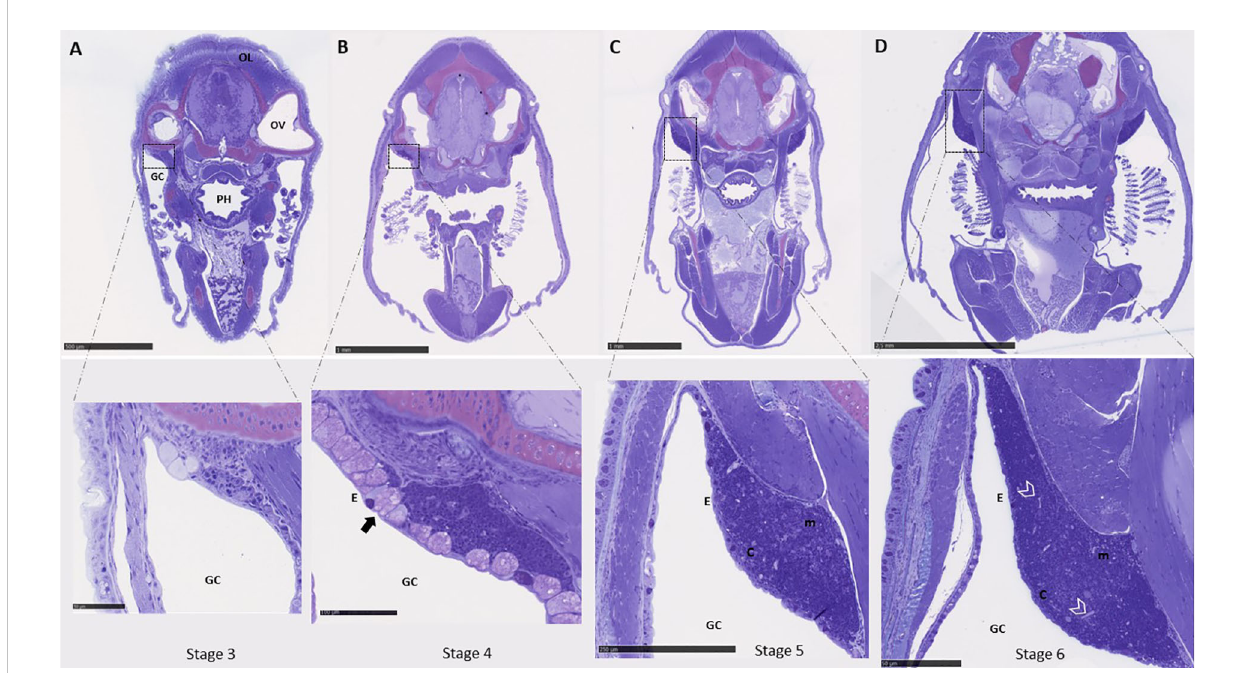
FIGURE 5 Histological examination of the thymus ontogeny in ballan wrasse. (A-D) show cross-sections of the whole head where the paired thymus can be observed dorsally in the opercular cavity. The left-side thymus is shown in higher magni fi cation. (A) Correspond to larvae in stage 3 (SL: 6-7,5 mm). (B) larvae in stage 4 (SL: 7,5-13 mm). Mucous-like cells within the epithelium are indicated by an arrow. (C) larvae in stage 5 (13-19 mm), and (D) larvae in stage 6 (19 to 30 mm). Blood vessels are delimited by arrow heads. OL, Optic lobes; OV, Optic vesicle; PH, Pharynx; GC, Gill cavity; E, Epithelium; c, cortex; and m, medulla. Scales bars are as follows: (A) above 500 m m and below 50 m m, (B) above 1mm and below 100 m m, (C) above 1 mm and below 250 m m, and (D) above 2.5 mm and below 50 m